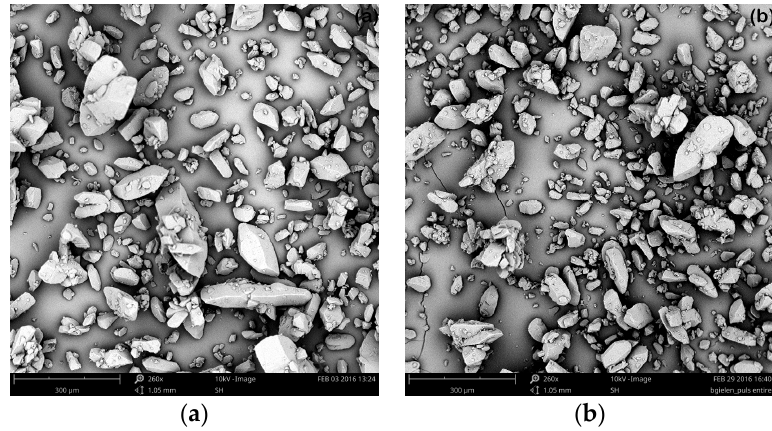
Figure 9 . Pulsed US applied during the cooling crystallization process of the API: ( a ) application after addition of 0.2 m% dry seed material; and ( b ) application to seed the solution and during cooling. The scale bar represents a length of 300 µm.